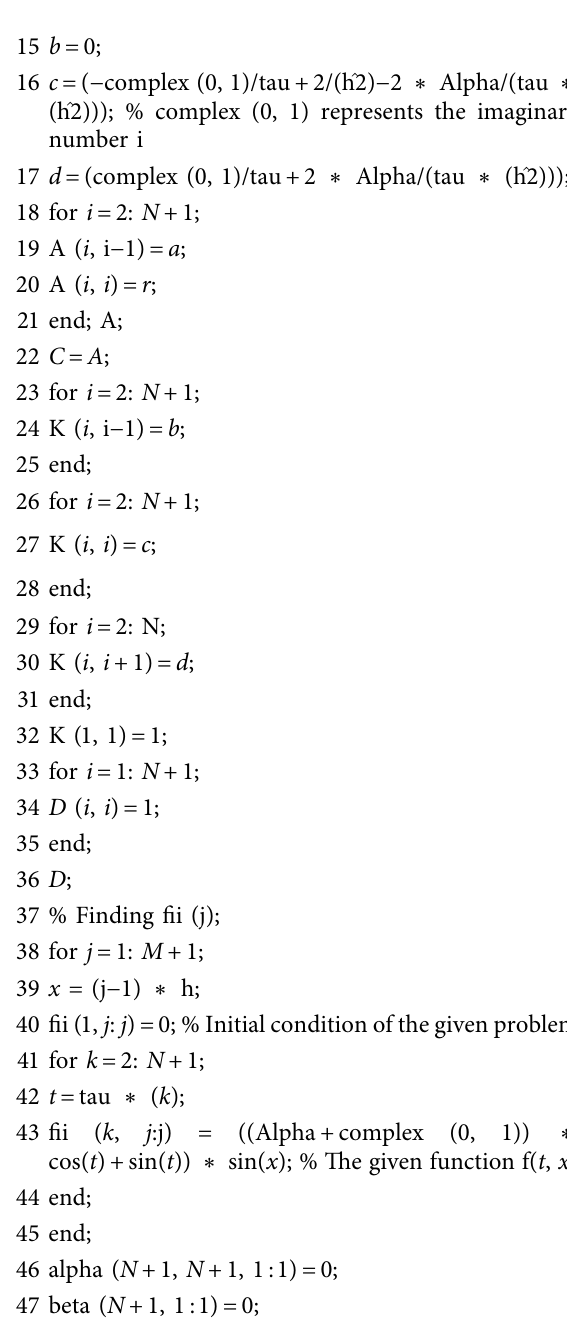
Figure 2: Profile evolution solution for system (22) at N � 120 and M � 108. (a) Approximate simulation for α � 0. (b) Approximate simulation for α � 0 . 00005. (c) Analytic